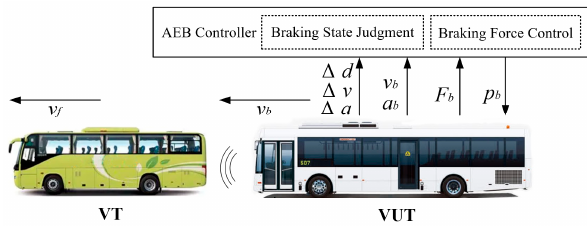
Figure 1. Schematic diagram of passenger car AEB system.